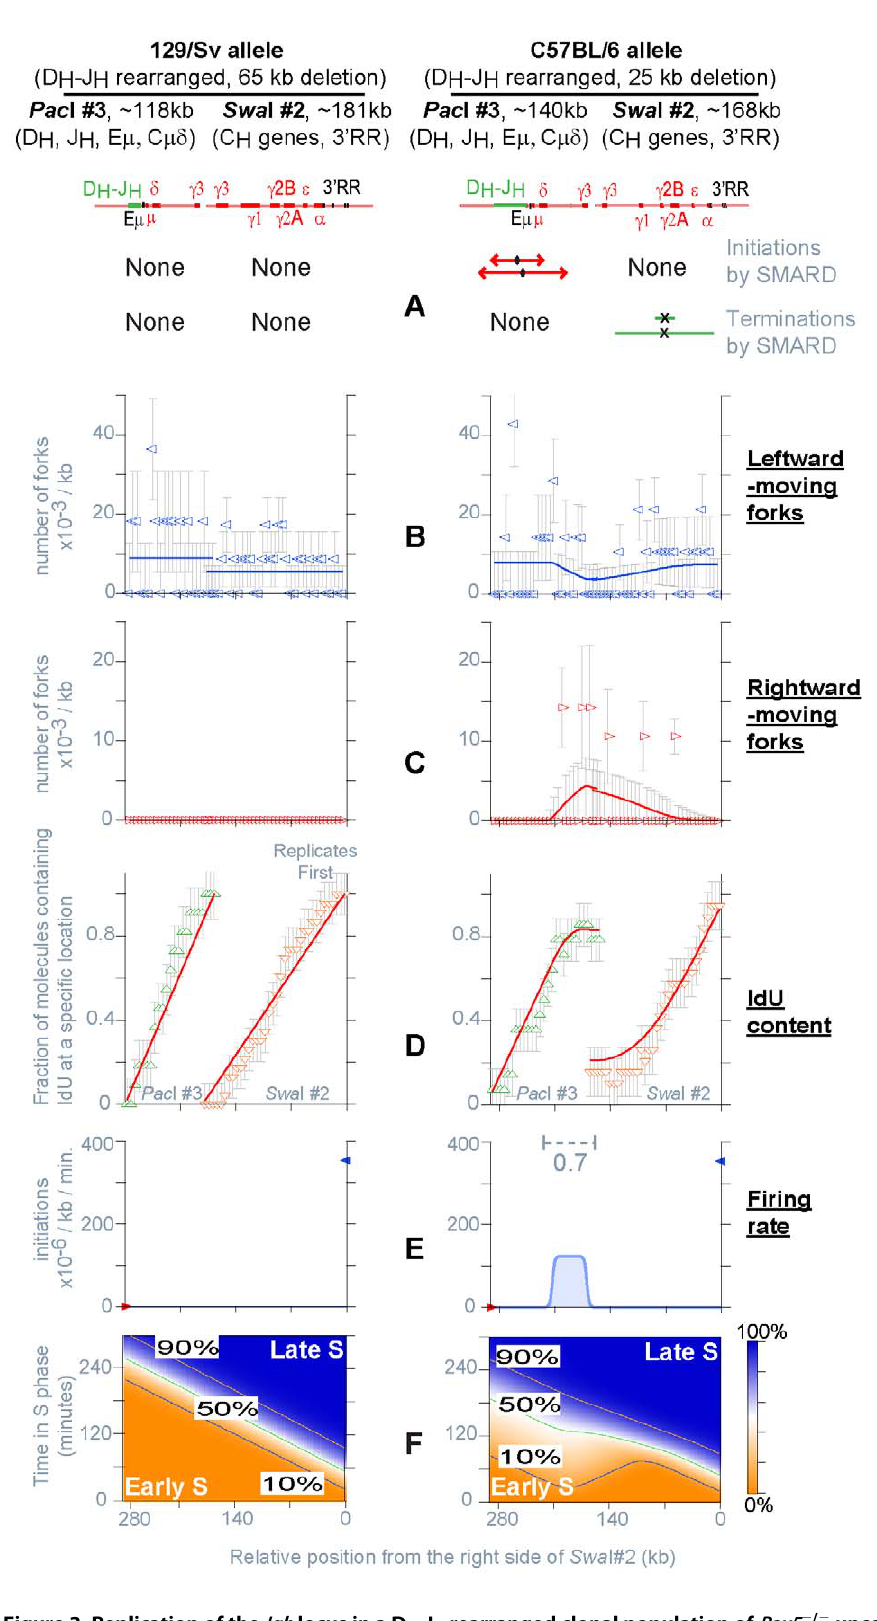
Figure 3. Replication of the Igh locus in a D H -J H rearranged clonal population of Pax5 2 / 2 uncommitted pro-B cells (129/Sv-C57BL/6). The results for each allele are shown separately. Only two restriction fragments were analyzed ( PacI # 3 and SwaI # 2). (A–F) Summary of the results obtained by SMARD from the analysis of 1,443 hybridization signals, yielding 532 fully substituted DNA molecules, 313 meeting the standards of